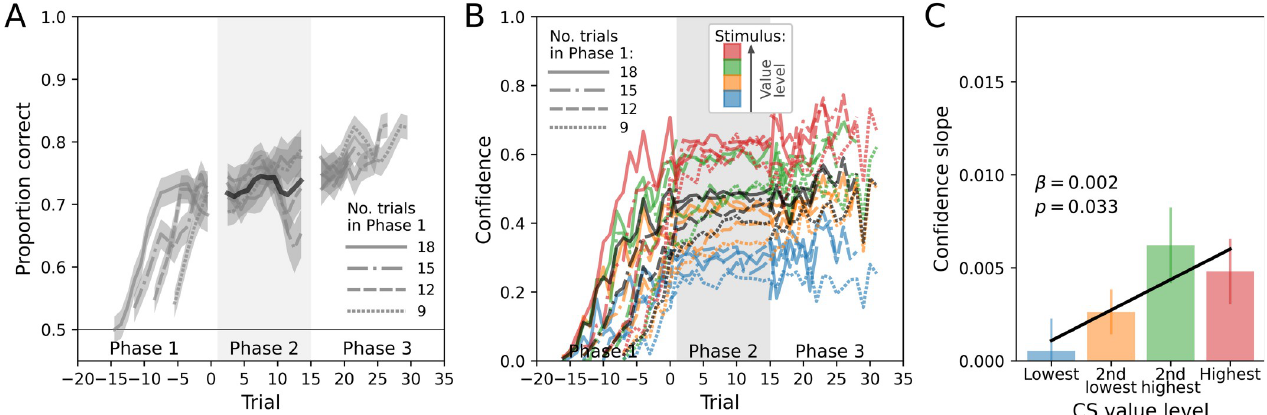
Fig 2. Performance and confidence. Block-averaged time courses are separated according to the duration of phase 1 (9–18 trials) and aligned to the beginning of phase 2. Shaded areas indicate standard error of the mean. (A) Value-based learning. The accuracy of choices gradually increased across the phases with feedback (phases 1 and 3), indicating that participants successfully learned the task. (B) Confidence. Reported confidence (normalized to [0; 1]) likewise increases across the course of a block. Black lines indicate averages across CS value levels. (C) Confidence increases in phase 2 in dependence of the CS value level. The parameter estimate β and the p-value are based on a linear model with value level as IV and average confidence slope in phase 2 as DV.